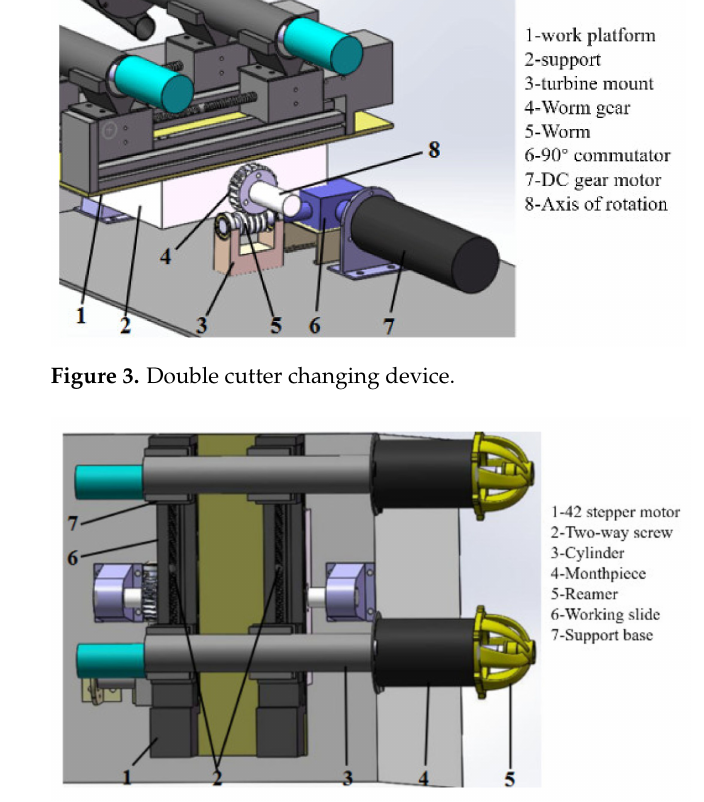
Figure 4. Double cutter transverse moving